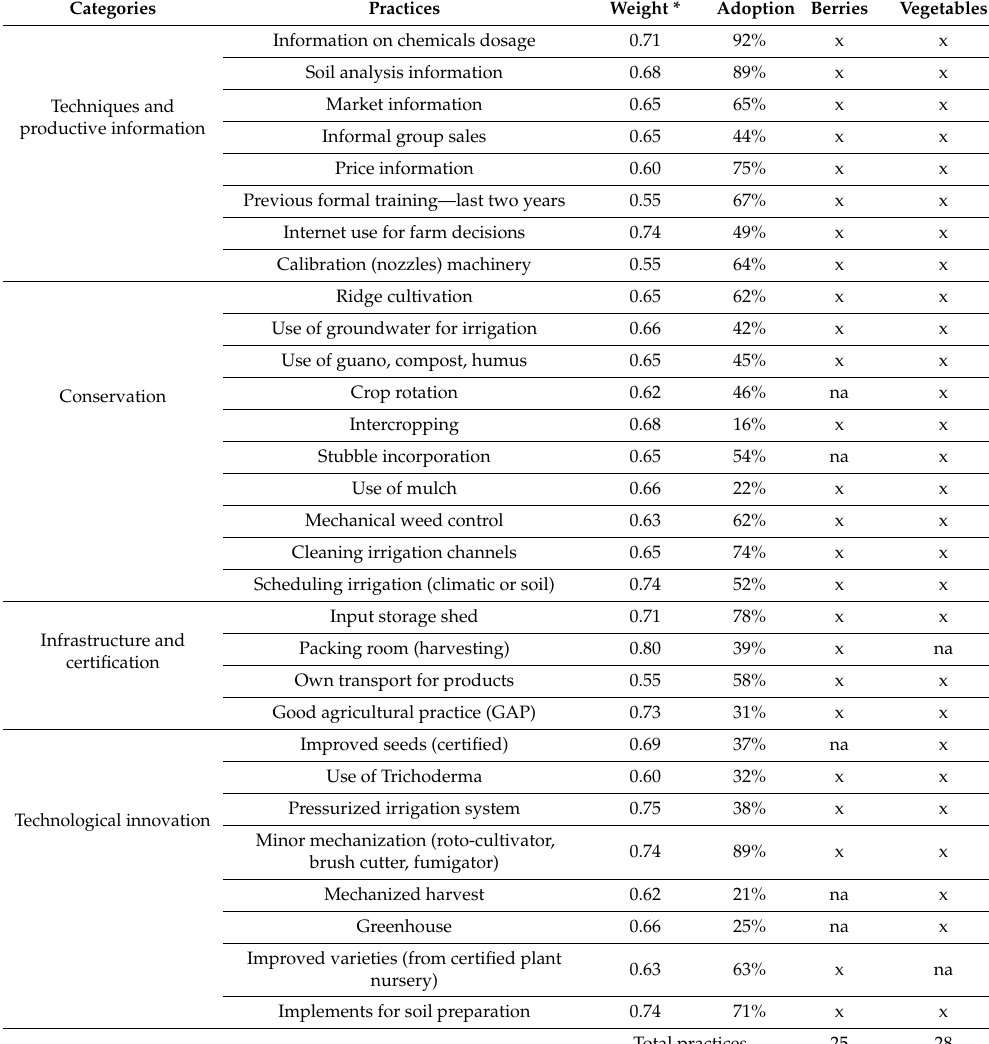
Table 2. Weights and adoption rates of various practices: berry and vegetable farmers.